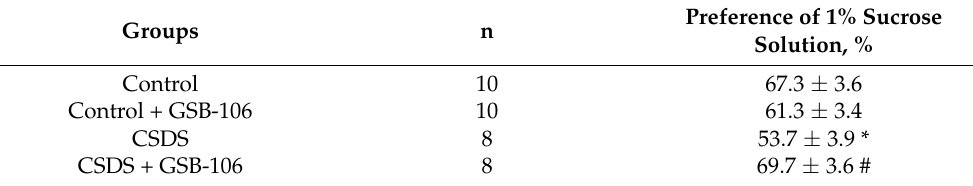
Table 3. Effect of dipeptide GSB-106 on sucrose preference in CSDS mice.